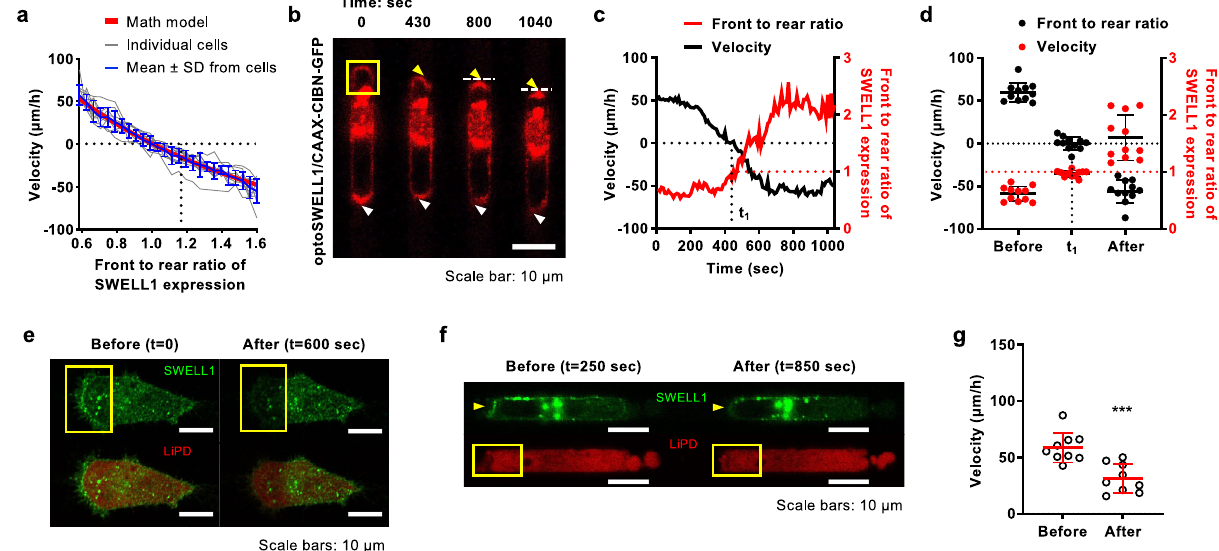
Fig.2|SWELL1polarizationcontrolscellmigrationdirectionandef fi ciency.a A multi-phase, steady-state mathematical model (shown in red), which accounts for actin-cytosol (water)-ions-coupled cell migration, was compared to experimental measurements from 11 individual cells subjected to optogenetic stimulation (shown in gray). Cells were obtained from three independent experiments. The model predicts that SWELL1 enrichment at the cell rear controls migration direc- tion and velocity, which is in line with the mean±SD of the experimental data (shown in blue). b Time-lapse montage of a representative MDA-MB-231 cell expressing OptoSWELL1 and CAAX-CIBN-GFP followinglight stimulationatthe cell leadingedgeinaregionenclosedbytheyellowbox.GradualSWELL1accumulation at the cell front (yellow arrowhead) is accompanied by reduction at the cell rear (whitearrowhead).Whitedashlinesdenotethe “ new ” trailingedge. c Instantaneous migration velocity (black line) and front to rear ratio of SWELL1 intensity (red line) of the cell shown in b . At t=430sec (t 1 ), SWELL1 is equally distributed at both cell